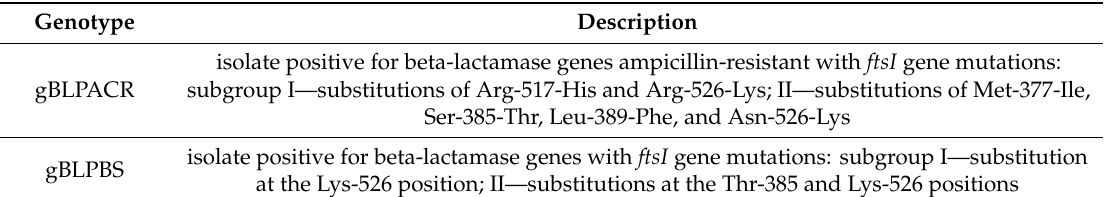
Figure 2. MIC Am values for ampicillin among Haemophilus parainfluenzae isolates from respiratory microbiota . S—susceptible isolates, I—susceptible, increased exposure (formerly intermediate) isolates, R—resistant isolates. 3.2. The incidence of β -Lactamase-Positive Isolates According to Phenotypic Methods In only 5.7% (5/87) of H. parainfluenzae isolates was the cefinase test. In 91.9% (80/87) of isolates, the benzylpenicillin zone diameter of growth inhibition was <12 mm, and those isolates were suspected to produce beta-lactamases and/or have PBP3 mutations. Additionally, amoxicillin – clavulanate-resistant (2/1 µg) isolates were reported in 2.3% (2/87) cases. According to the results of